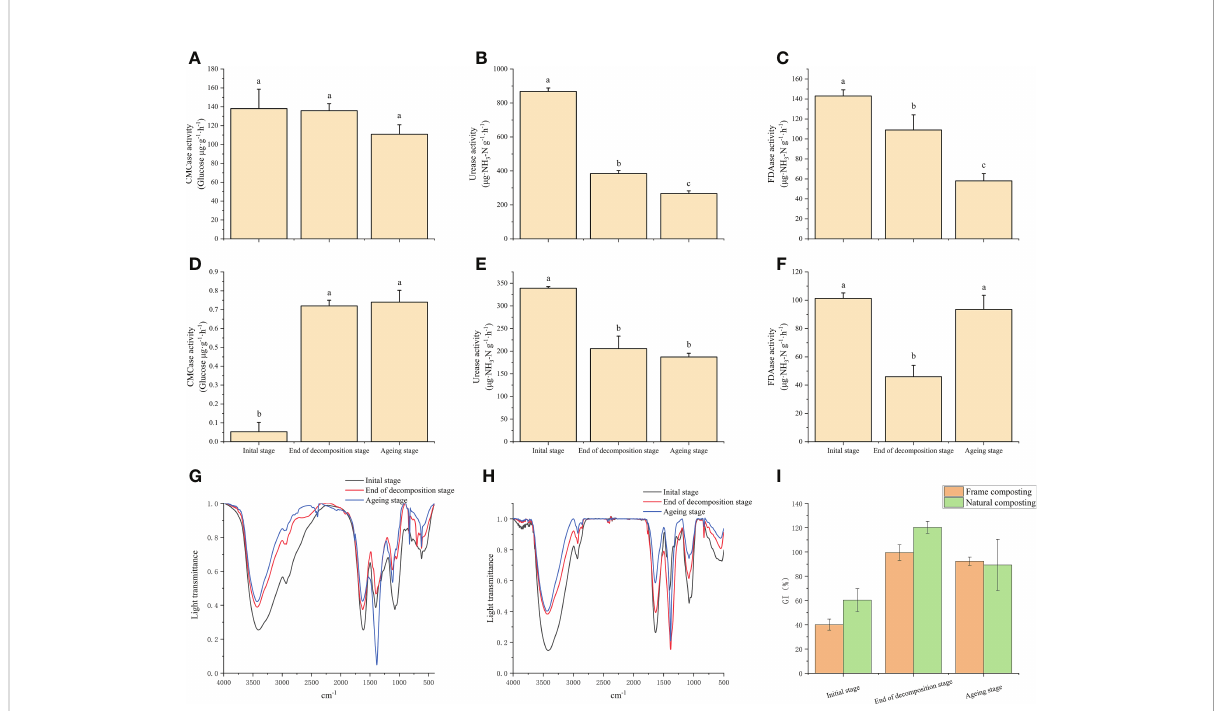
FIGURE 2 Changes in physicochemical parameters and decay indicators under natural and frame composting methods: (A) cellulose activity variation during frame composting; (B) urease activity variation during frame composting; (C) Changes in fl uorescein diacetate hydrolase activity during frame composting; (D) cellulose activity variation during natural composting; (E) urease activity variation during natural composting; (F) Changes in fl uorescein diacetate hydrolase activity during natural composting; (G) Infrared absorption spectra of material leachate at different stages of frame composting; (H) Infrared absorption spectra of material leachate at different stages of natural composting; (I) Effect of leachate on wheat seed germination index at different stages of frame composting and natural composting. Data represent the mean ± SD of at least three independent experiments, and different lowercase letters indicate that differences between different treatment groups reached signi fi cance at the P<0.05